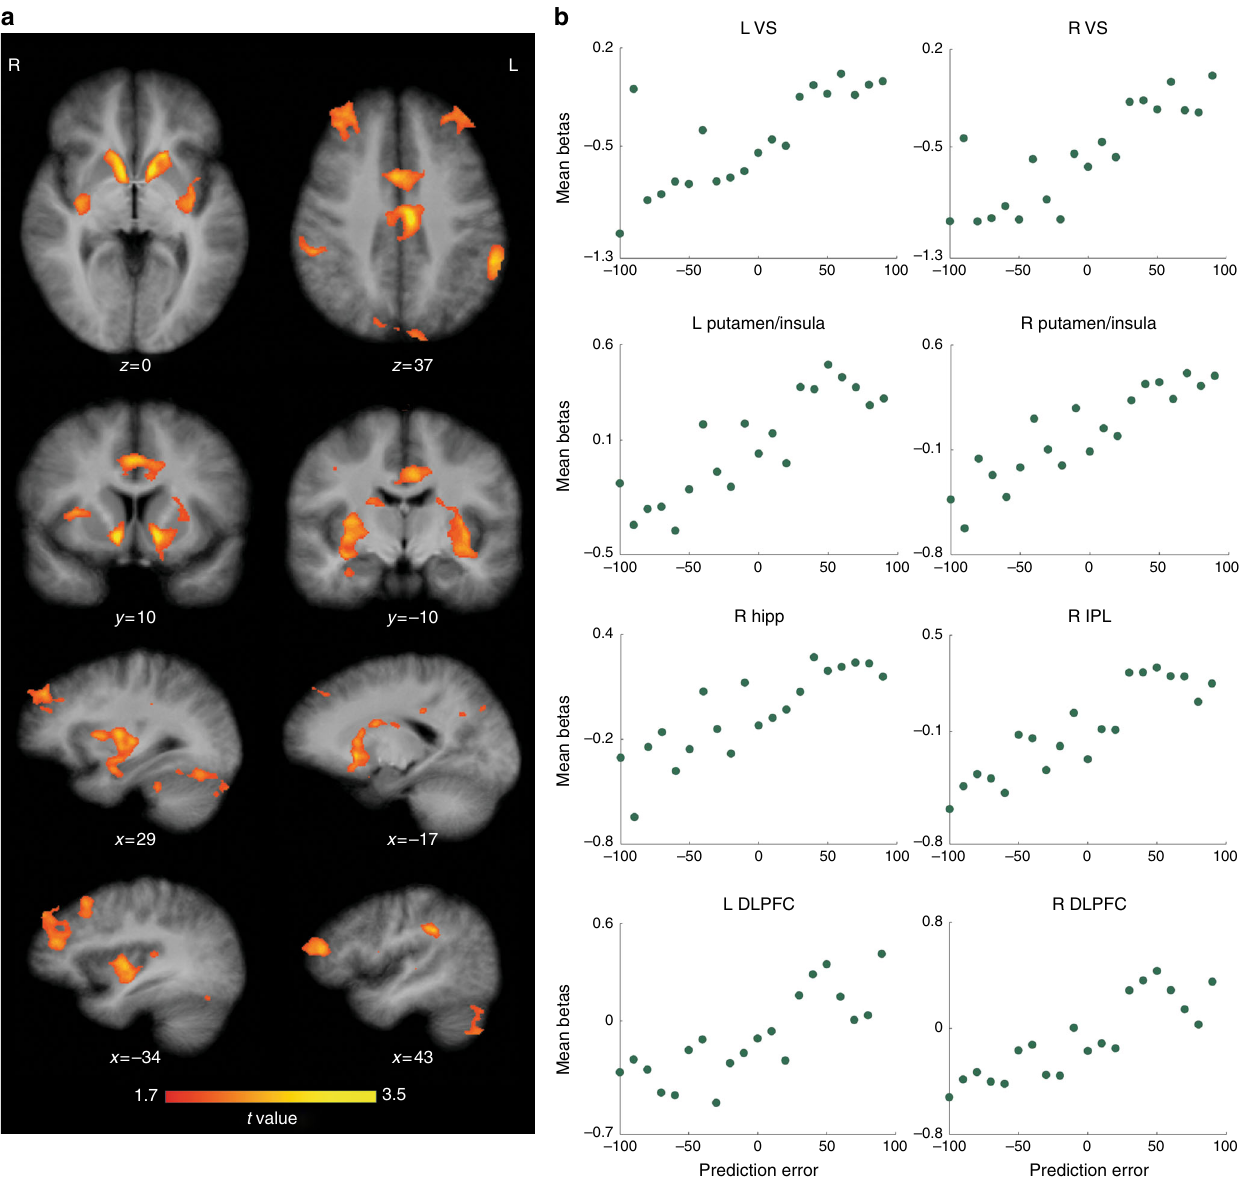
Fig. 3 Brain regions correlating with PE magnitude and valence during feedback. a Substantial clusters of activity were observed bilaterally in ventral and dorsal striatum, DLPFC, cingulate cortex, inferior parietal cortex, and precuneus (Supplementary Table 1). Within the striatum, one cluster was centered on the NAc and another in posterior areas of the putamen/claustrum, extending through to insula and (on the right) anterior MTL. b Activity in these regions parametrically varied with the signed PE on each trial, such that the greatest responses were elicited by better-than-expected outcomes (feedback for correctly answered questions stated with low con fi dence — large positive PE events), and the smallest responses by worse-than-expected events (feedback for incorrect answers stated with high con fi dence — large negative PE). Importantly, responses to fully predicted outcomes (zero PE feedback, whether for correct or incorrect answers) lay in the middle. The plots depict average single-trial beta estimates for each PE value, within selected